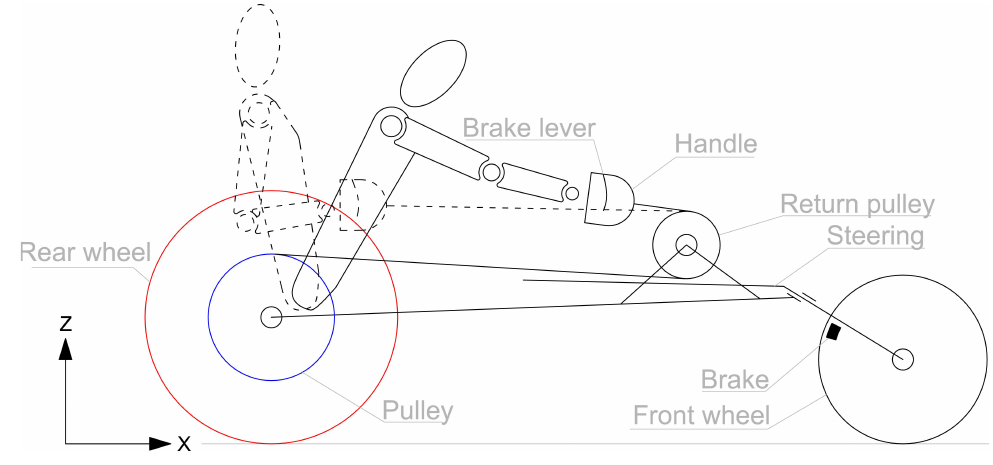
Figure 4. Innovative system applied to the racing